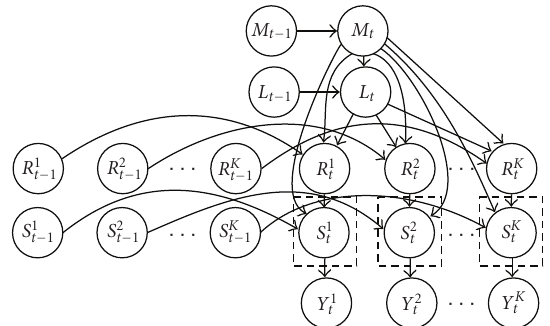
Figure 7: Single time slice of the DAG corresponding to the overall dominant Shape quality inference